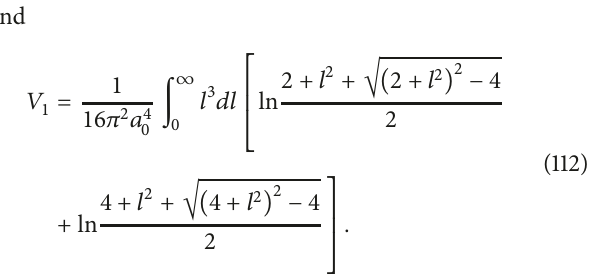
Figure 10: The numerical value of (𝑁𝑎 0 ) 4 𝑉 푁 for the model whose theory space is associated with 𝑌 푁 as a function of 𝑁 . The dotted lines indicate (𝑁𝑎 0 ) 4 𝑉 푁 , where 𝑉 푁 is the vacuum energy density in the real scalar theory whose mass matrix is Δ(𝐶 푁 )/𝑎 2 0 , and the constant −3𝜁(5)/4𝜋 2